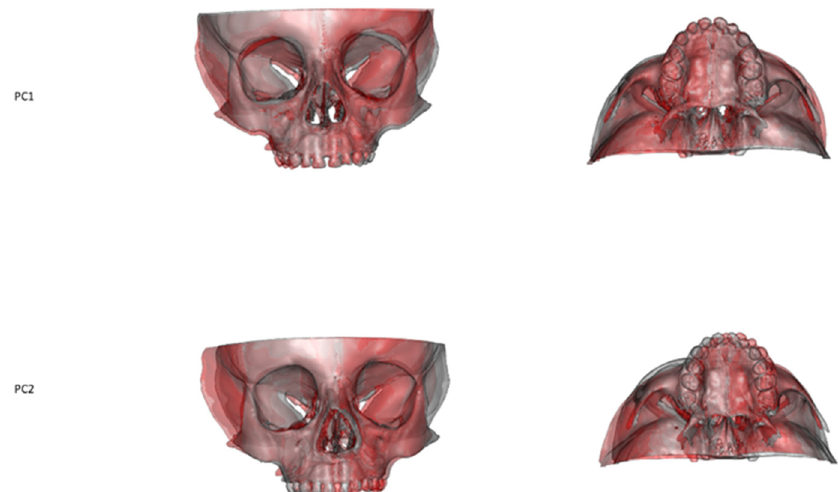
Figure 9. Surface warpings of the extremes of PC1 ( top ) and PC2 ( below ) of the asymmetric PCA. The grey surface indicates minimum (negative) values while the red surface indicates maximum (positive) values along the PCA axes. Values of shape variations have been magnified to a factor of 10 to highlight shape differences.